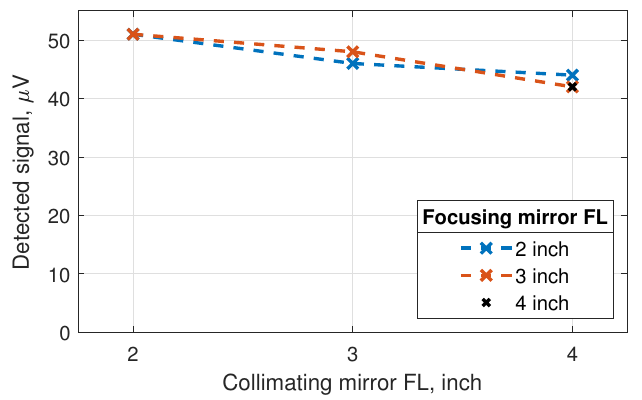
Figure 5. Detected signal for various combinations of paraboloidal mirrors M 1 and M 2 with different focal lengths (FLs); for the set-up, see Figure 4. The optimization of the configuration for the best radiation coupling was performed with the electrically chopped ceramic